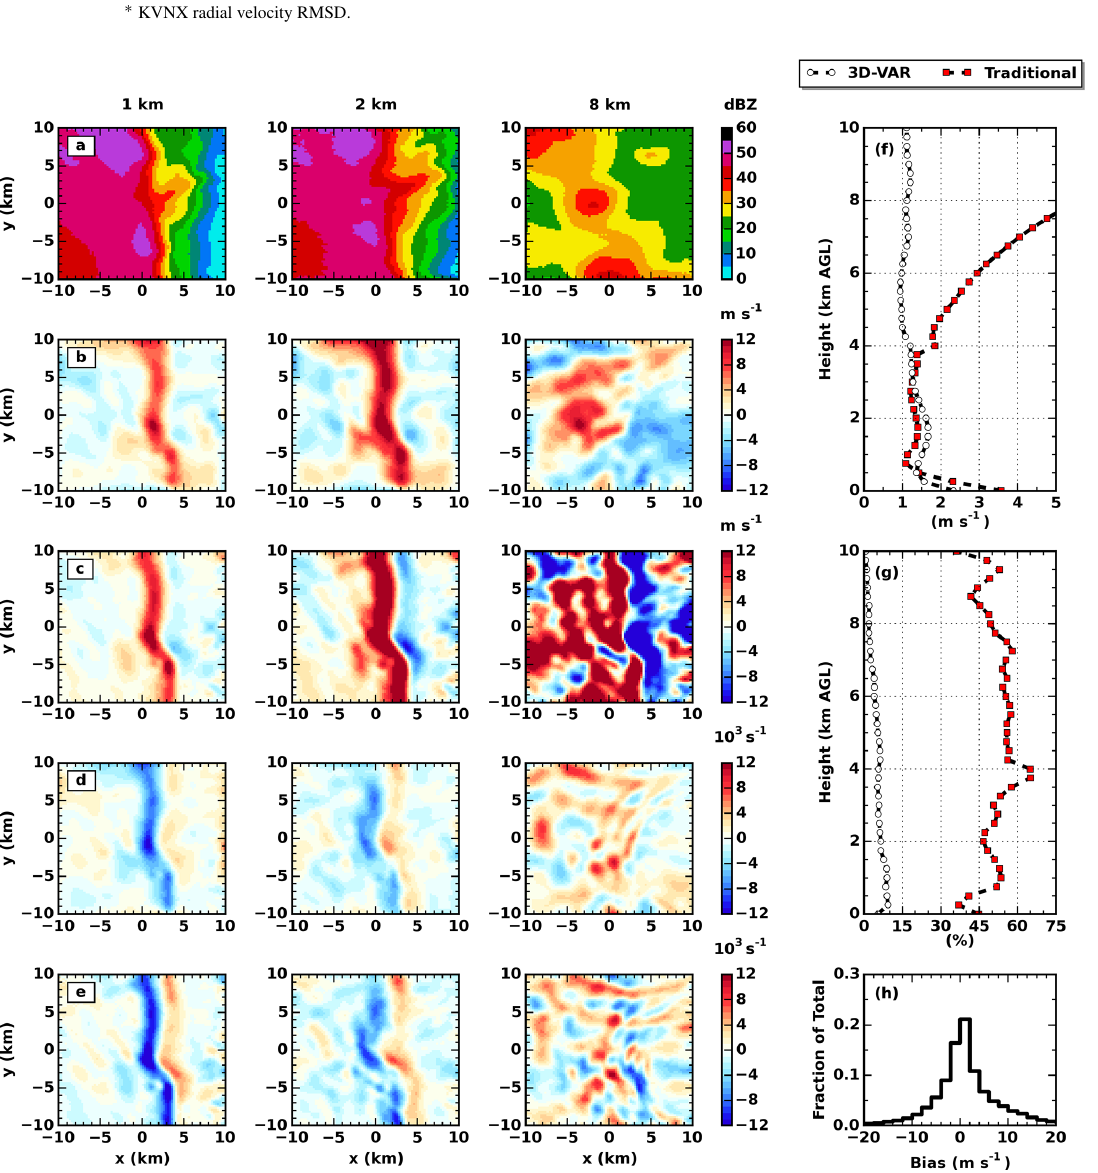
Figure 6. Comparison of 20 May 2011 squall line wind retrieval between 3DVAR and iterative upwards integration technique, showing (a) radar reflectivity, (b, c) 3DVAR and iterative vertical air motion, respectively, (d, e) 3DVAR and iterative horizontal wind divergence, respectively, (f) CSAPR-I7 radial velocity RMSD profile, (g) NMCR profile, and (h) vertical air motion bias (3DVAR minus iterative; 2ms − 1 bin width). Select heights for panels (a–e) are 1km, 2km, and 8kma.g.l. Origin in panels (a–e) corresponds to